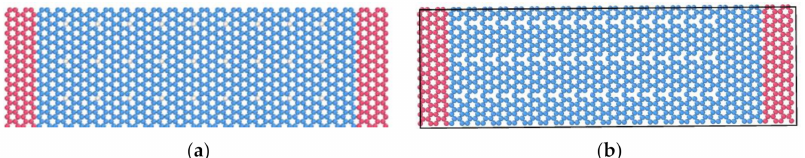
Figure 6. Schematic diagram of the graphene nanoribbon model with different concentrations. ( a ) Graphene nanoribbons with a vacancy concentration of 2.647%. ( b ) Graphene nanoribbons with a vacancy concentration of 5%.